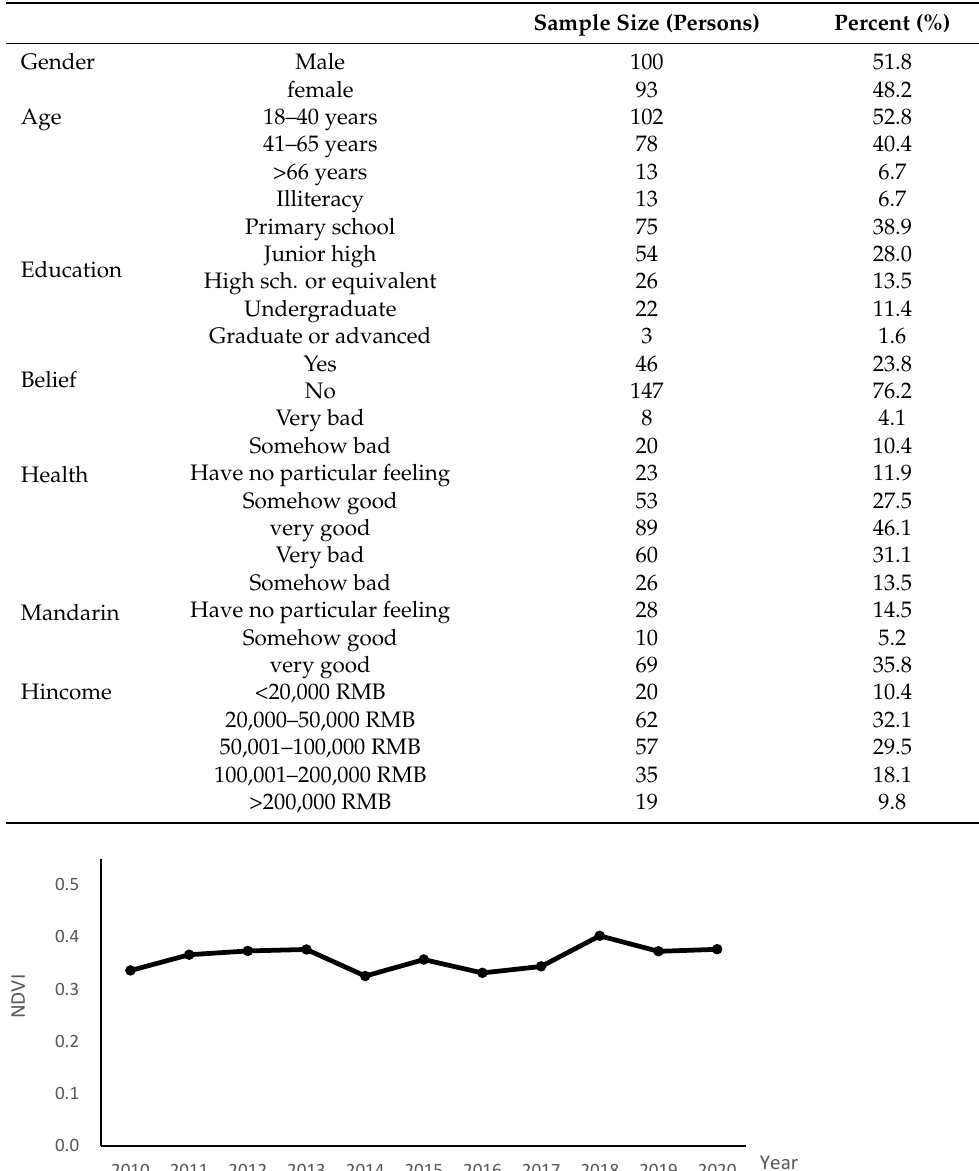
Table 2. Socio-demographics distribution of herders in the sample.